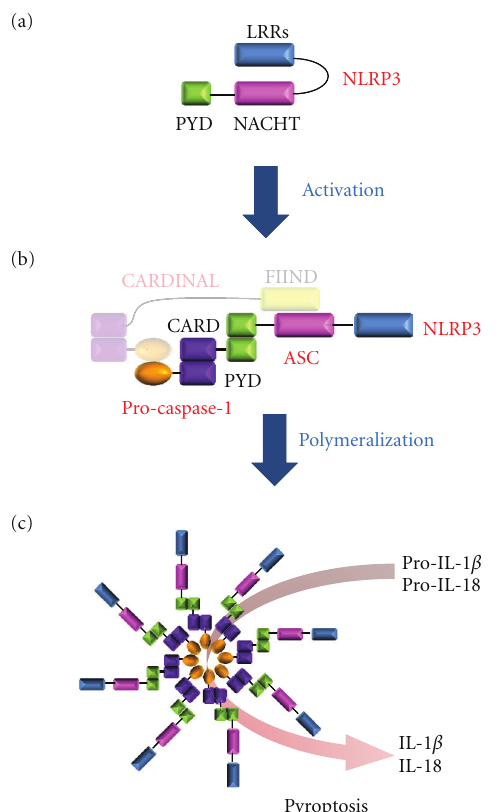
F 1: Assembly of the NLRP3 in�ammasome. (a) Without an activator, NLRP3 is autorepressed by the interaction between LRRs and the NACHT domain. (b) NLRP3 activator opens up NLRP3 and allows to interact with ASC. ASC further interacts with procaspase-1. Although a CARDINAL homolog is not present in mice, we showed human CARDINAL, shown with a shade, as a part of the human NLRP3 in�ammasome complex. (c) NLRP3 units polymerize. Active caspase-1 processes maturation of IL-1 18. Pyroptosis is also induced by activated